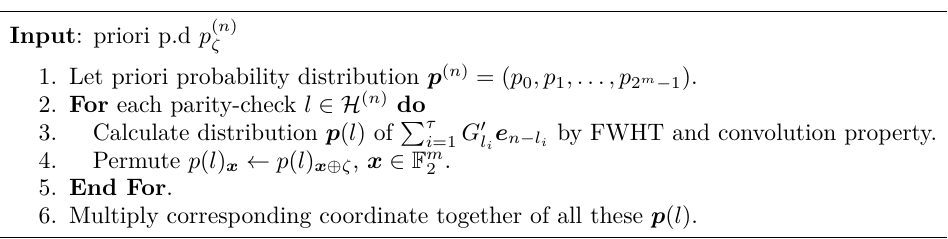
Algorithm 2 Calculate the nominator